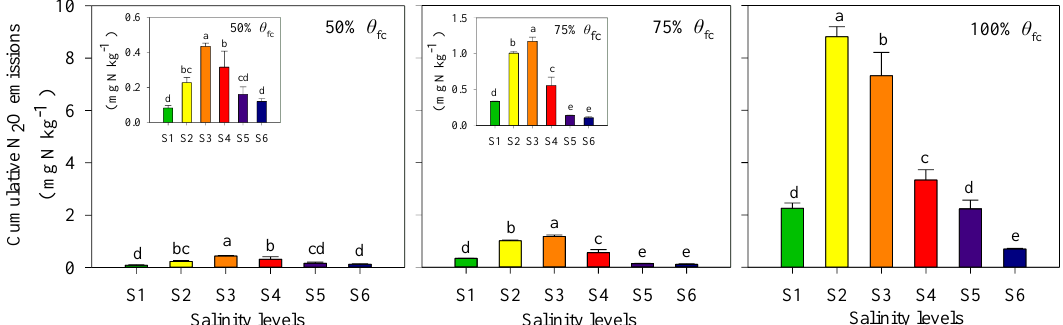
Figure 4. Cumulative N 2 O emissions during the incubation period. S1, S2, S3, S4, S5 and S6 represent six levels of soil salinity, 0.25, 1.01, 2.02, 3.21, 4.92 and 6.17 dS m − 1 , respectively. The inserts in 50% θ fc and 75% θ fc enlarge the ordinate to show di ff erences more clearly. Di ff erent lowercase and uppercase letters indicate significance levels of p < 0.05 among salinity treatments, respectively. Error bars indicate standard error of mean ( n = 3). Table 2. Two-way ANOVAs for NH 4+ -N consumption, NO 2- -N accumulation, NO 3- -N accumulation and N 2 O emissions. Different lowercase letters indicate significance levels of p < 0.05 among salinity treatments, respectively.